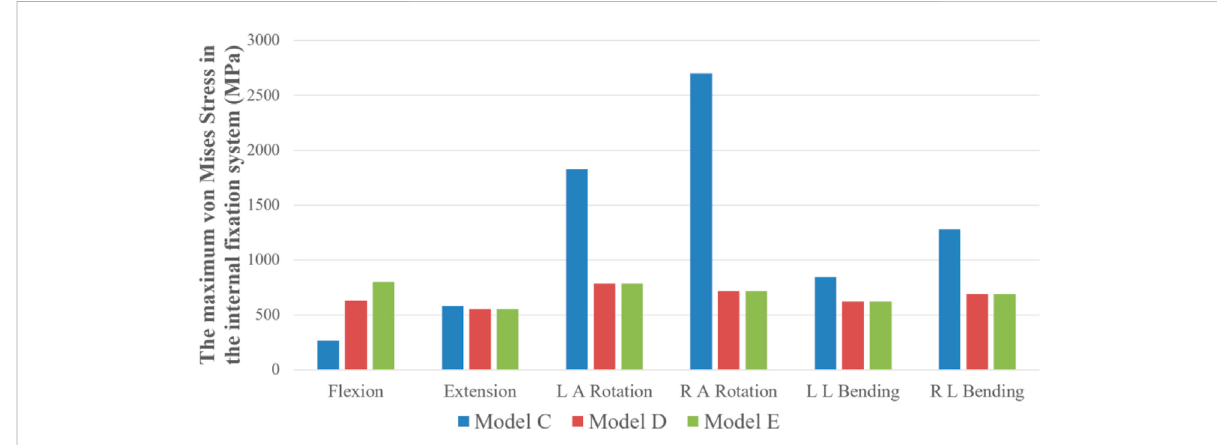
FIGURE 9 The maximum von Mises stress on the internal fi xation system of Model C, D, and E under six states of motion.